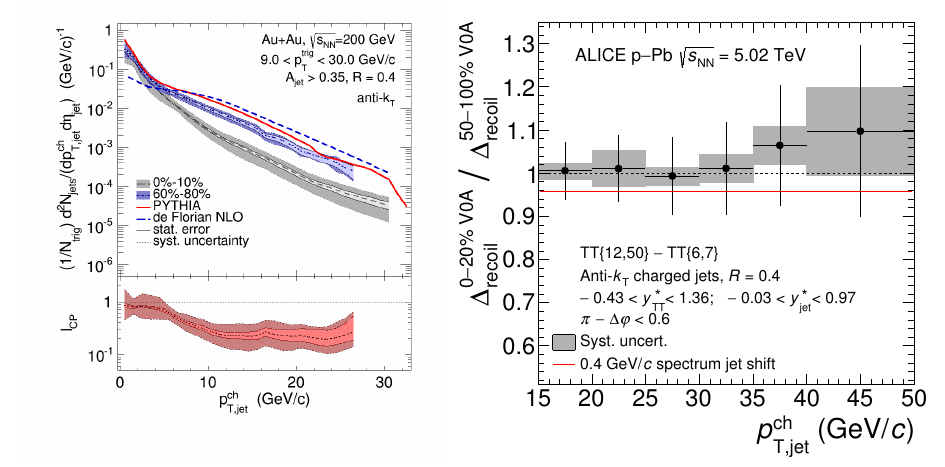
Figure 5. Left: The semi-inclusive recoil jet distribution in di ff erent centrality bins and compared to di ff erent model comparisons in Au-Au collisions at √ s NN = 200 GeV, the ratio of central to peripheral yield is shown on the bottom [10]. Right: the ratio of ∆ recoil in central to peripheral p-Pb collisions at √ s NN = 5 . 02 TeV